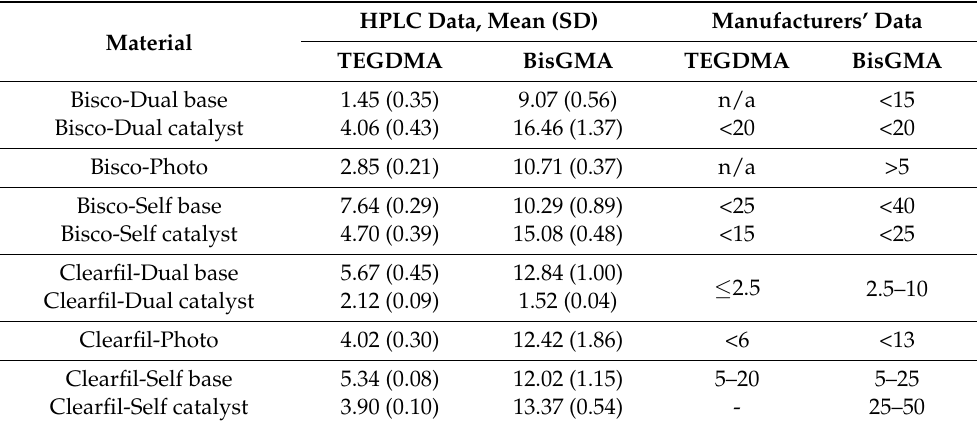
Table 2. Differences in the percentage by weight (wt%) of TEGDMA and BisGMA in uncured materials experimentally obtained using high performance liquid chromatography (HPLC) and stated by the